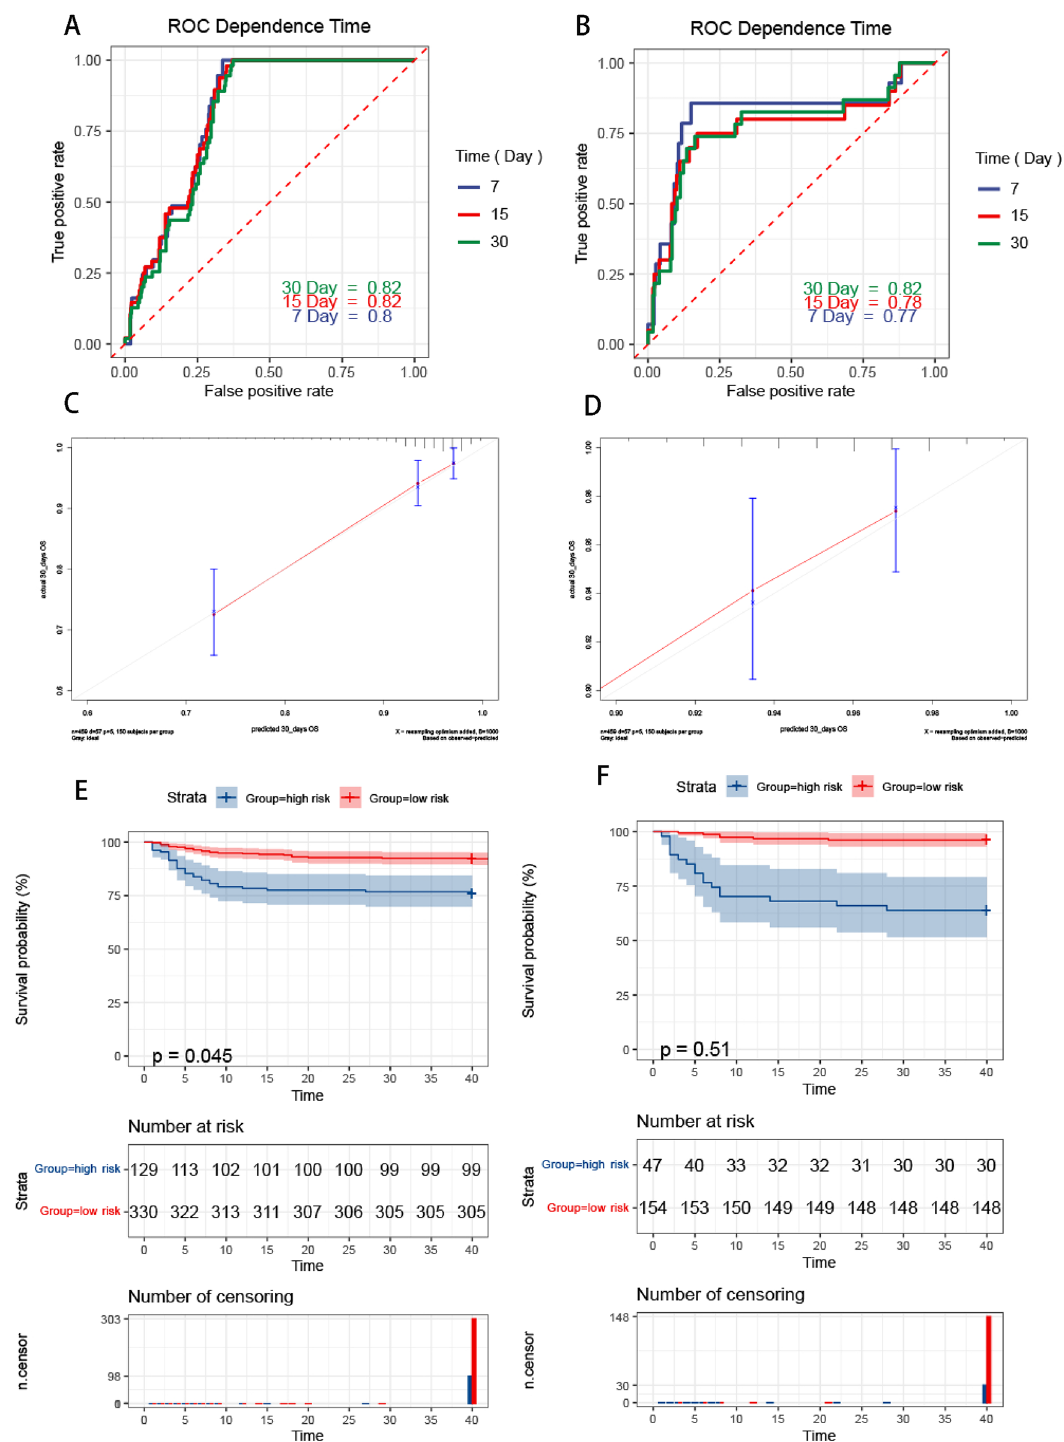
Figure 3. Estimation of the model. ROC curve in training cohort ( A ). ROC curve in testing cohort ( B ). Time- dependent ROC curve analysis of survival prediction by the prognostic model. Calibration curves in training cohort ( C ). Calibration curves in testing cohort ( D ). The Y-axis represents actual survival, as measured by K–M analysis, and the X-axis represents the model-predicted survival. Survival analysis of patients with GNB in the training ( E ) and testing ( F ) sets. The K–M survival curves show the overall survival based on the high and low- risk patients divided by the optimal cut ‐ off